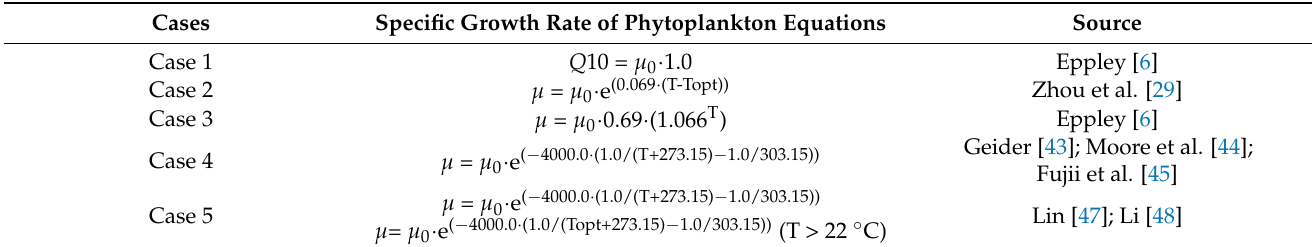
Table 2. Five kinds of the specific growth rate of phytoplankton equations in the coupled model (T opt = 22 ◦ C).